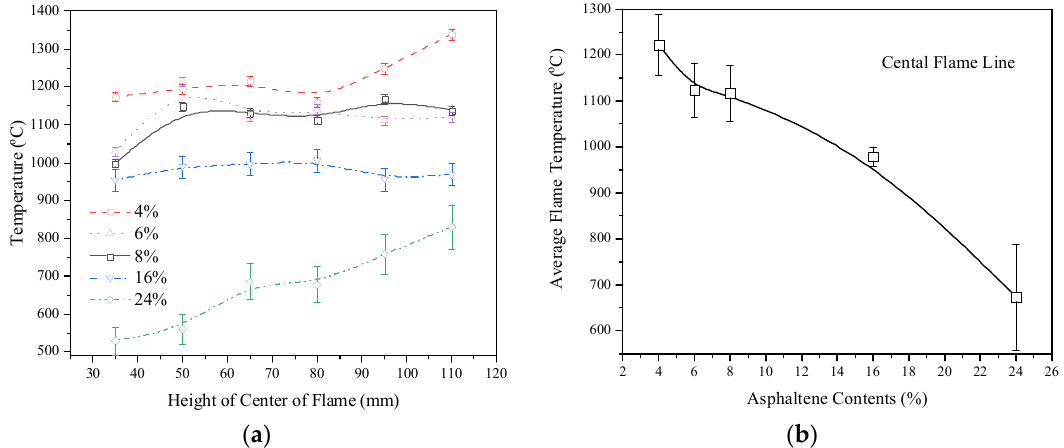
Figure 6. In-flame temperature measurements on the centerline of the flame. ( a ) Center flame temperature profiles. ( b ) Average flame temperature.